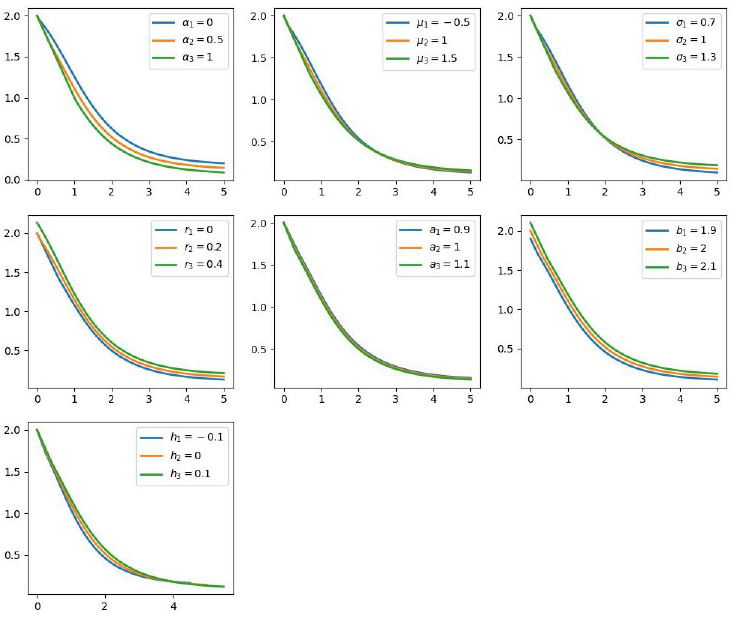
Figure 4. Each figure shows the graph of V ( x ) for three different values of the indicated parameter. The fixed parameters in each graph are chosen as α = 0.5, µ = 0.2, σ = 1, r = 0.1, a = 1, b =